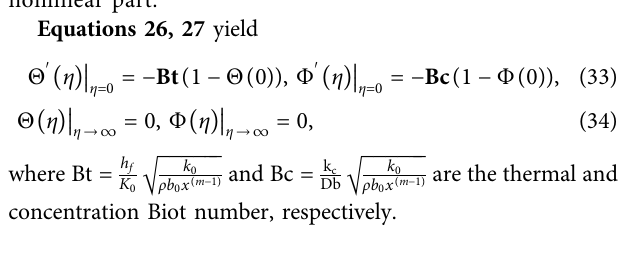
veri fi ed if Θ w (cid:2) 1, whereas Θ w > 1 corresponds to the nonlinear part.